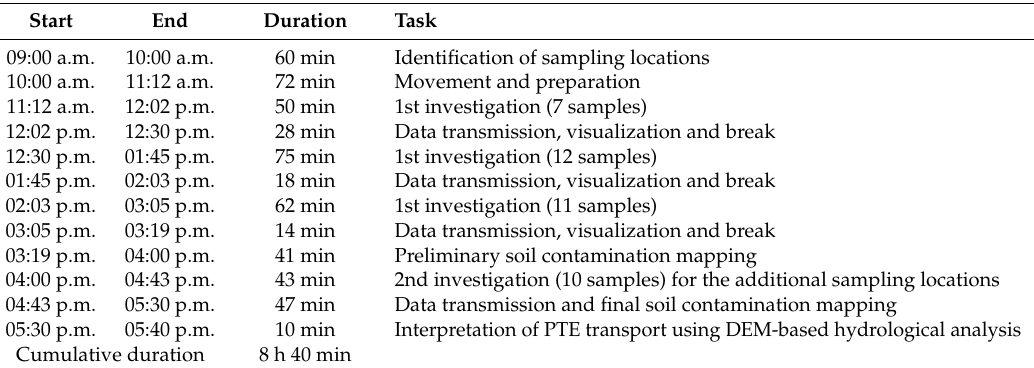
Table 1. Time duration for each task.